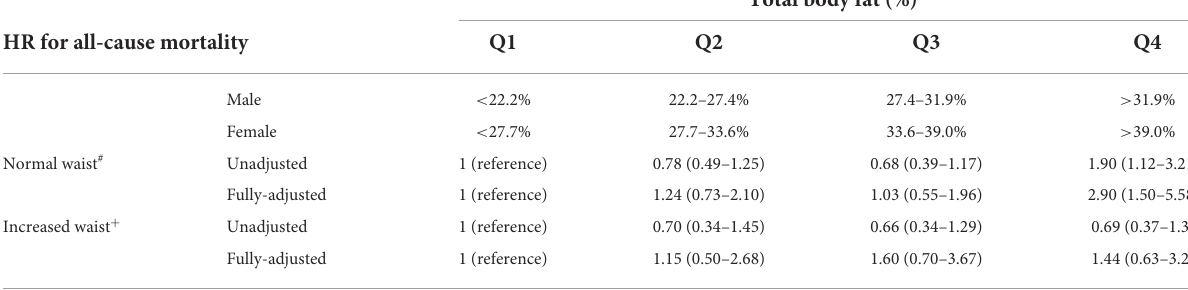
TABLE 5 Hazard ratios for all-cause mortality based on total body fat percentage and waist circumference.